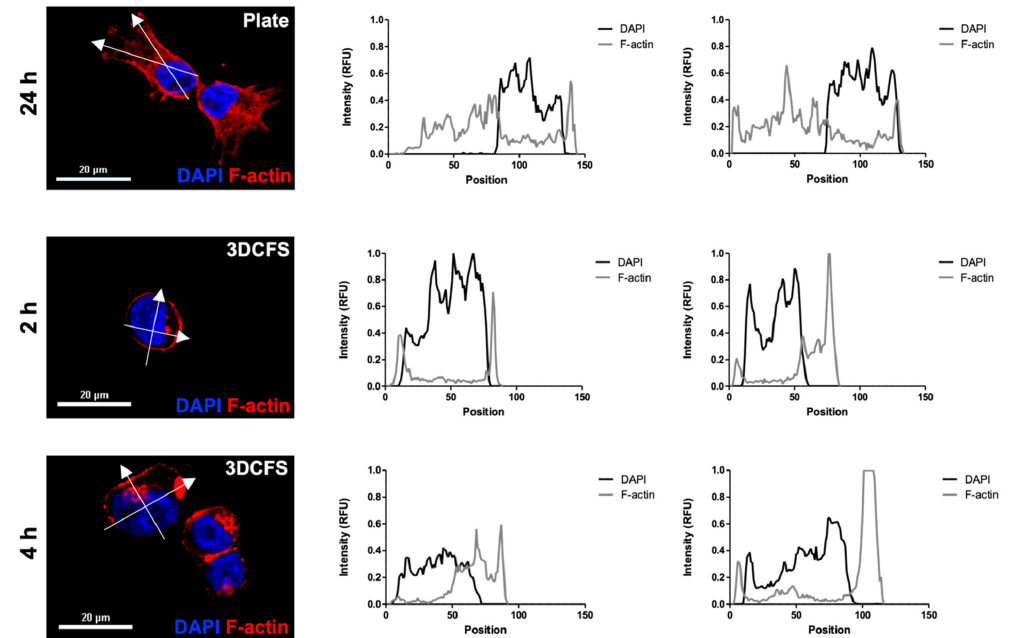
Figure 5. A375 F-actin density. Actin filaments of A375 cells were stained using rhodamine phalloidin and their intensity profile was measured at relevant time points for each system. ( a ) 24 h incubation in adherent conditions; ( b ) 2 h incubation in the 3DCFS; ( c ) 4 h incubation in the 3DCFS. Each cell’s intensity profile was analyzed and compared on the vertical and horizontal axis. The actin density was found to be higher in adherent conditions, indicating an elevated stiffness of the cells. Scale bar: 20 µm.